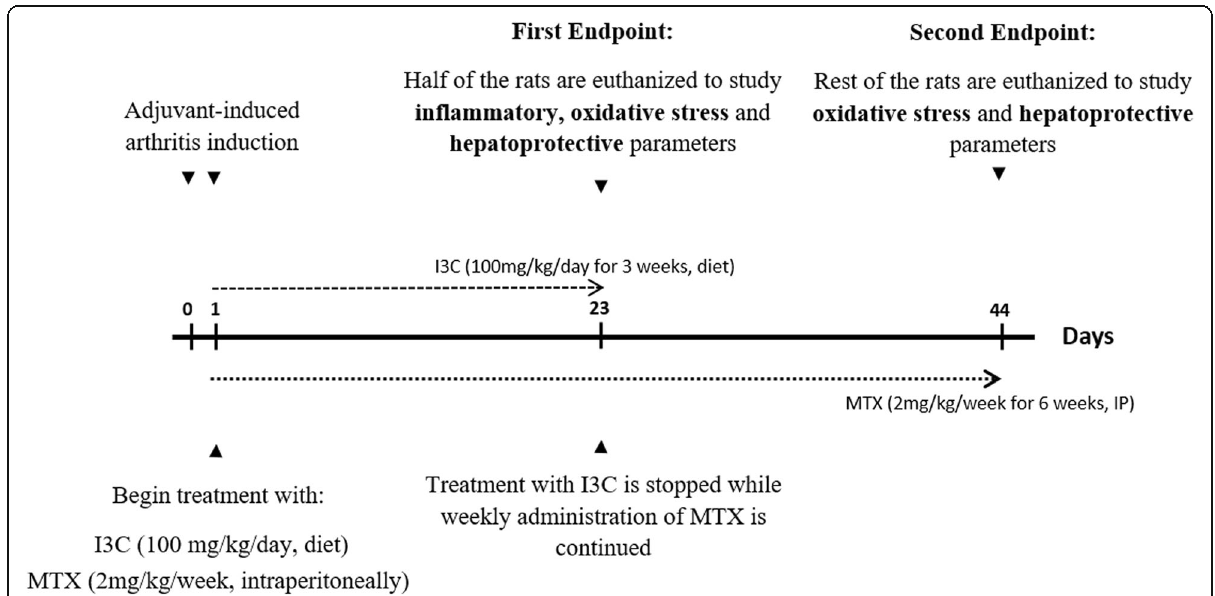
Fig. 1 Experimental design: Induction of arthritic experimental model was accomplished on day 0 and 1. Treatment with I3C began on day 2 and lasted for 21days only. Cessation of the treatment with I3C done to examine the prolonged hepatoprotective effects of I3C against the continued weekly injections of MTX. Treatment with MTX was administered weekly up to 6weeks. Inflammatory markers were investigated only on the first endpoint (day 23) considering the inflammation that was induced on days 0 and 1 would resolve beyond the third